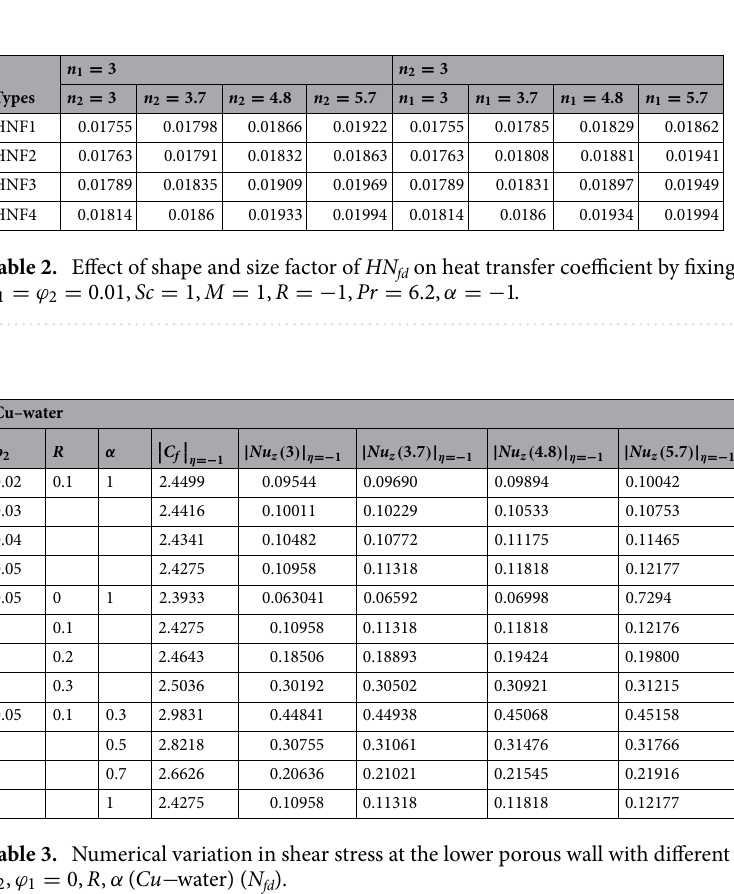
Table 1. Thermophysical features of HN fd and NP’s.